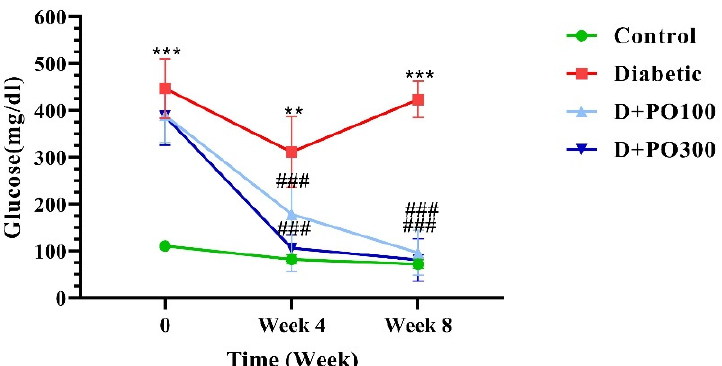
Figure 3. The effects of PO extract on blood glucose levels in diabetic rats. The data are presented as mean ± SD. Repeated measures two-way ANOVA test was carried out with the following Tukey– Kramer’s post hoc test; ** p < 0.01, *** p < 0.001 vs. control group; ### p < 0.001 vs. diabetic group.